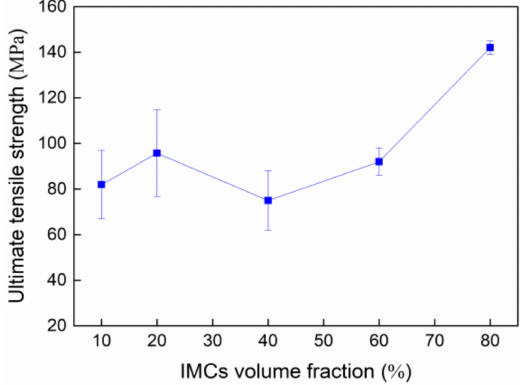
Figure 6. Ultimate tensile strength as a function of IMC volume